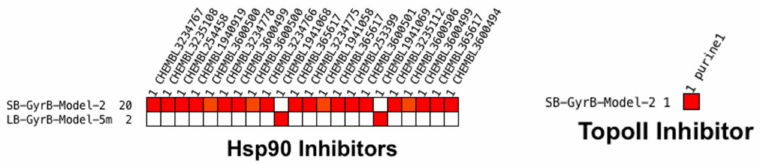
Figure 7. Heatmaps were obtained after screening 649 of the most potent Hsp90 inhibitors (K d < 100 nM) and 21 TopoII inhibitors using 5 GyrB 3D-pharmacophore models. SB-GyrB-Model- 2 retrieved both Hsp90 and TopoII inhibitors, and LB-GyrB-Model-5m retrieved only 2 Hsp90 inhibitors. None of the other GyrB models retrieved compounds from the Hsp90 and TopoII